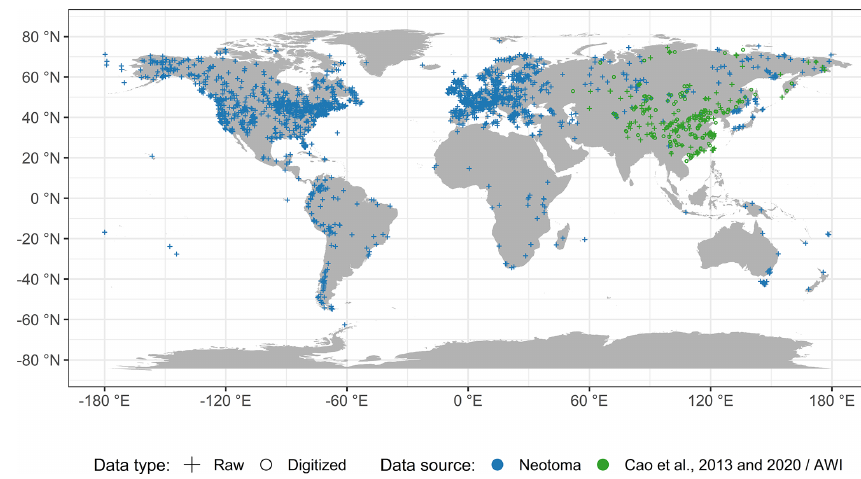
Figure 1. Map of the 2831 records for which standardized chronologies were established by source and data type.